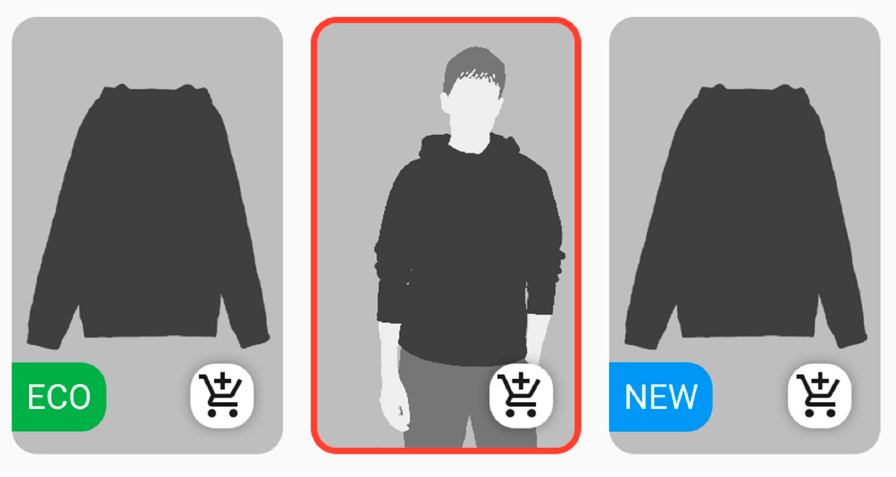
Figure 3. Product highlight types used. (The pictures of clothes and models are illustrative).